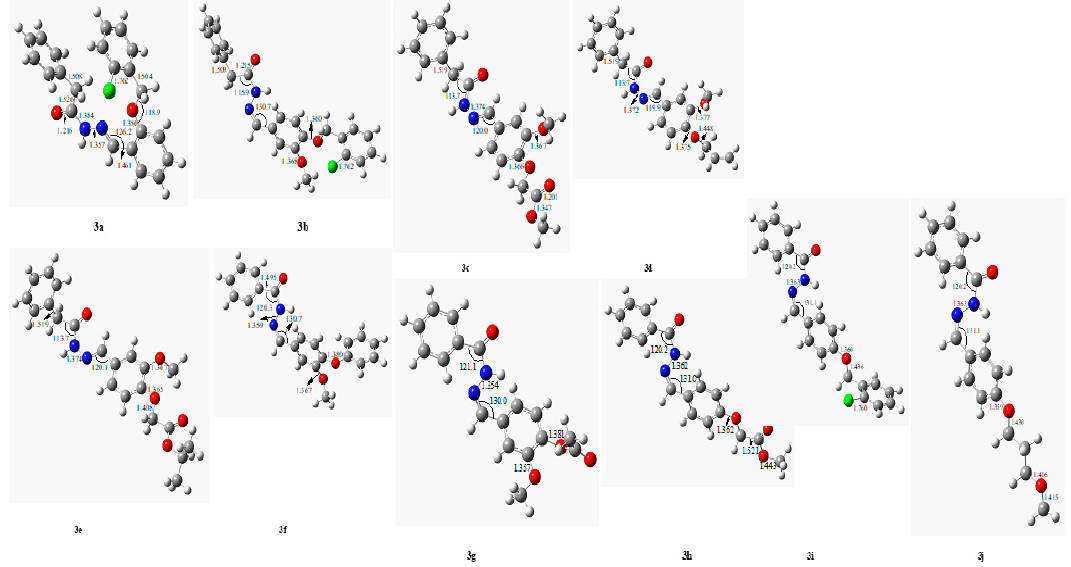
Figure 3. The B3LYP-optimized geometries of 3a – 3j (bond lengths in Å and bond angles). Table 2. Calculated quantum chemical Table 1. Glide docking score for the best docked molecule, 3e, along with interacted amino acid residues against various antimicrobial targets.